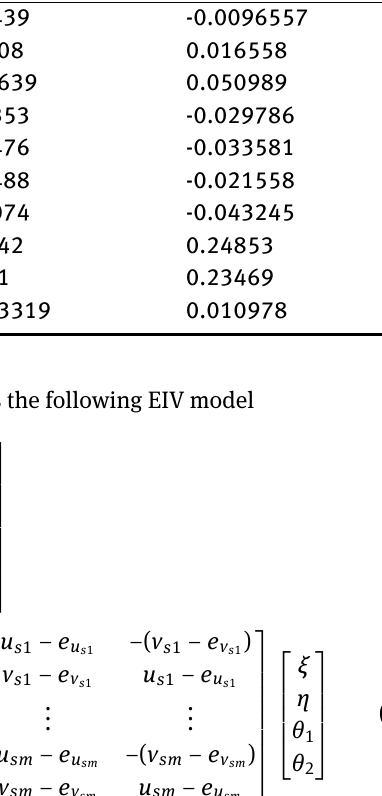
Table 5: The corresponding residuals of observations and coeflcient matrix by WTLS and SWTLS. WTLS SWTLS